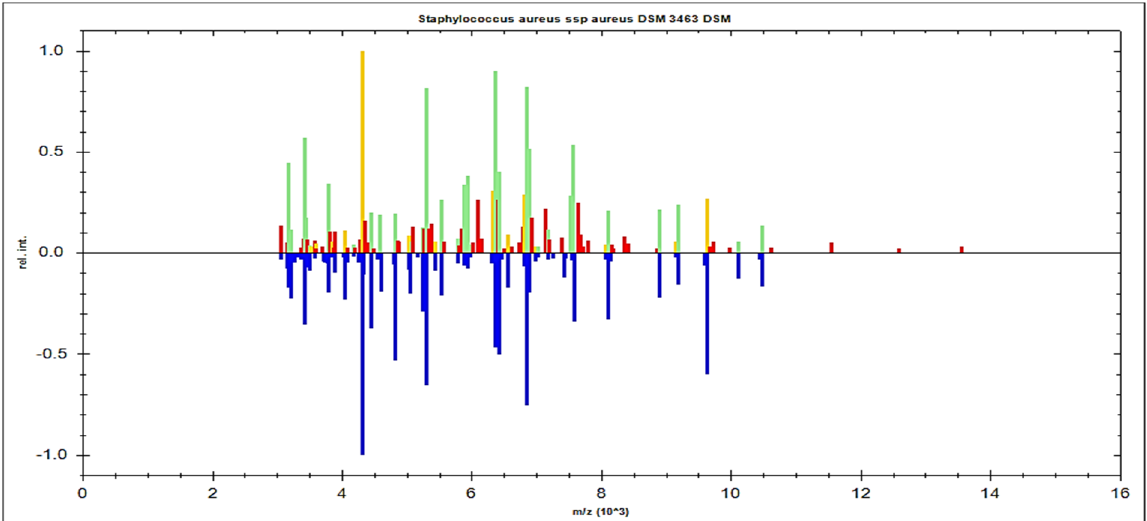
Figure 1. S. aureus spp. aureus DSM 3463 DSM was used as a reference strain to compare spectral protein profiles obtained from clinical specimens. The blue color in the bottom section of the spectrum represents the deposited peaks that were utilized to fit the sequence; the green color in the top section of the spectrum represents extremely well-matched peaks; and the red and yellow colors represent misaligned and transitional peaks, in both.